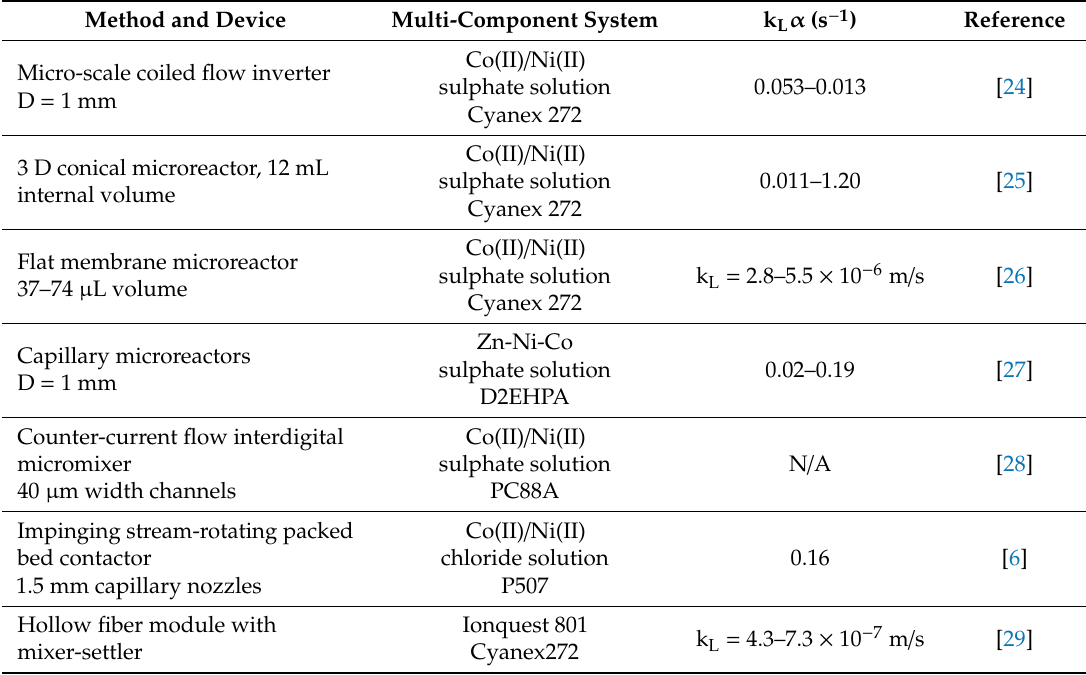
Table 1. Summary of experimental investigations of Co / Ni separations in intensified